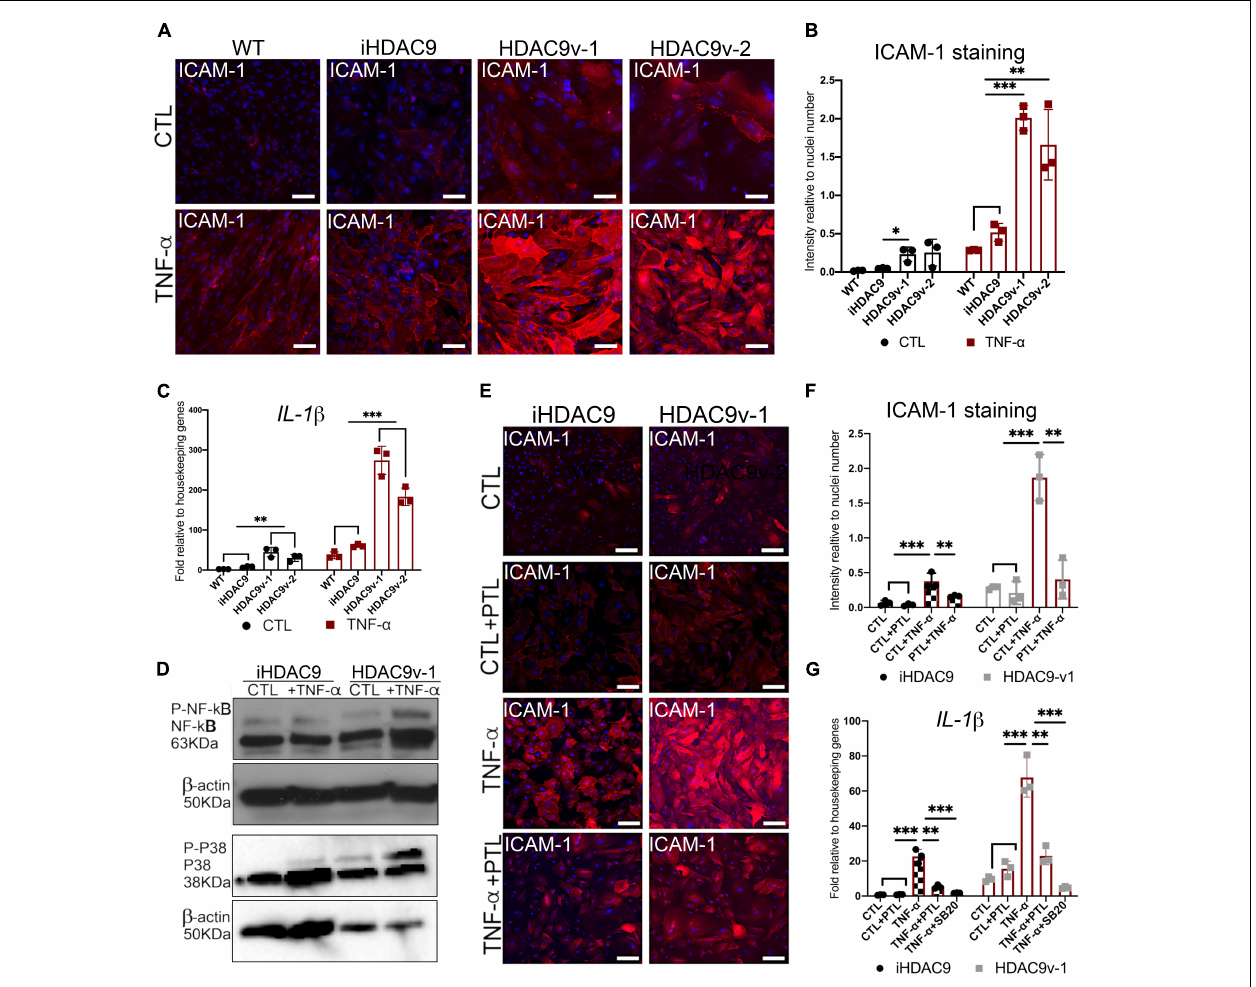
FIGURE 5 | The HDAC9 risk variant promotes inflammation in SMC through NF- κ B activation. (A) Cell surface ICAM-1 immunostaining in WT, iHDAC9, HDAC9v-1, and HDAC9v-2 SMC control (CTL) and upon TNF- α stimulation for 24 h (TNF- α ) and (B) quantification of ICAM-1 staining relative to cells number (nuclei). (C) RT-qPCR profile for IL-1 β in WT ( n = 3), iHDAC9, HDAC9v-1, and HDAC9v-2 SMC CTL and upon TNF- α treatment. (D) Cropped blot of Phospho- NF- κ B, total NF- κ B, Phospho- p38, total p38, and correspondent β -actin in iHDAC9 and HDAC9v-1SMC CTL and SMC treated with TNF- α (correspondent quantification in Supplementary Figure 4G ). (E) ICAM-1 immunofluorescence analysis in iHDAC9 and HDAC9v-1 SMC CTL (DMSO), and SMC upon TNF- α stimulation alone and with the NF- κ B inhibitor Parthenolide (PTL; 5 µ mol/L) and (F) ICAM-1 staining quantification relative to cell number (nuclei). (G) Expression profile for IL-1 β in SMC untreated (CTL), treated with PTL or a specific p38 MAPK inhibitor, SB203580 (SB20; 1 µ M), with and without TNF- α stimulation. Nuclei were stained with DAPI. Scale bar = 100 µ m. The result is representative of three independent experiments (means ± SD). ∗ P < 0.05; ∗∗ P < 0.01; ∗∗∗ P < 0.001. Statistical analysis